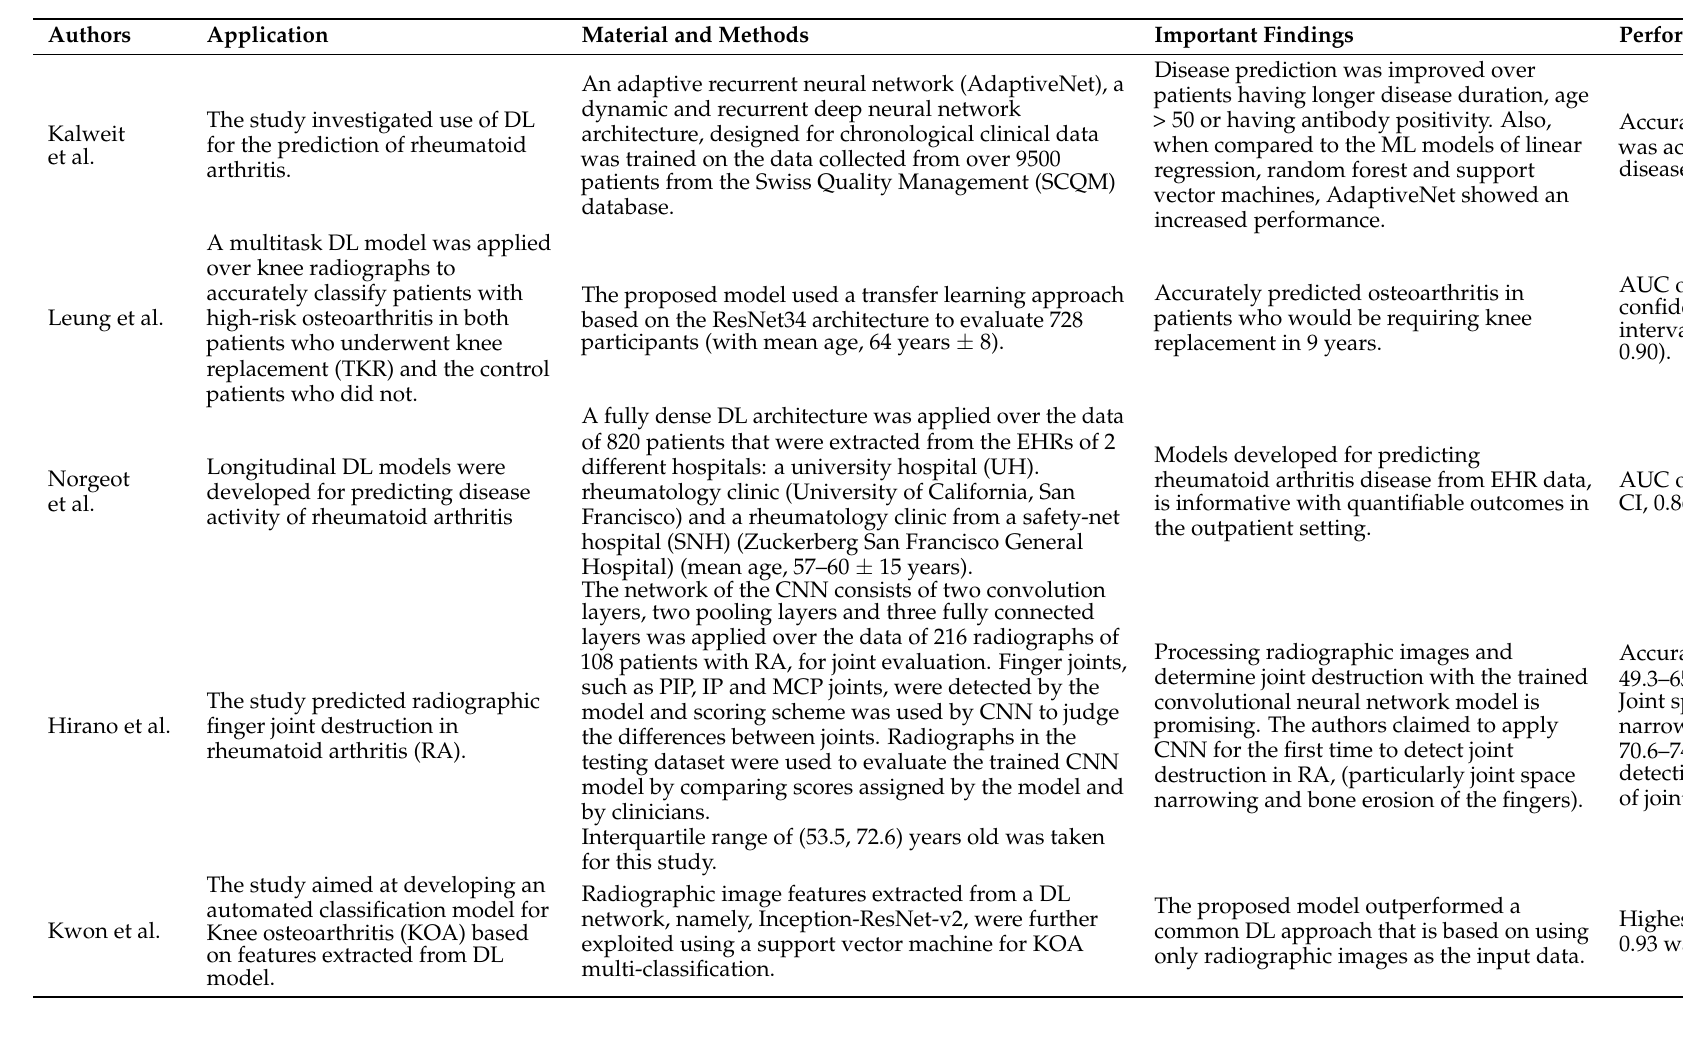
Table A3. Application of DL in